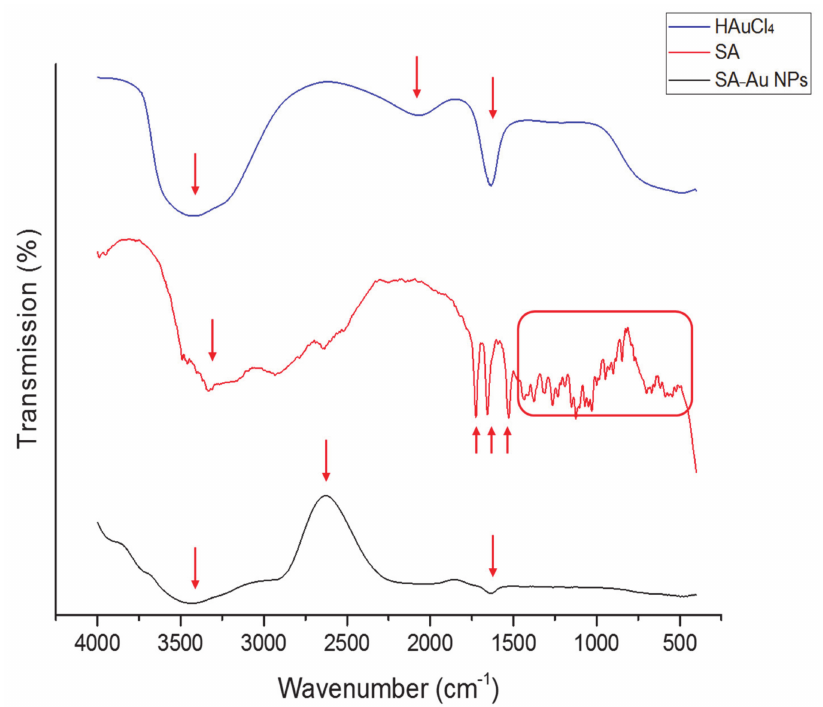
Figure 3. FTIR spectroscopy transmissions of SA, HAuCl 4 (diluted in deionized water), and SA-Au NPs, showing the distinctive peaks of SA at 1724, 1655, 1434 and between 1500 to 500 cm − 1 that disappeared in the SA-Au NPs, while an enhanced absorption peak at approximately 2695 cm − 1 and the C=O stretching at 1650 cm − 1 that presented in these NPs spectrum suggesting the successful preparation of the